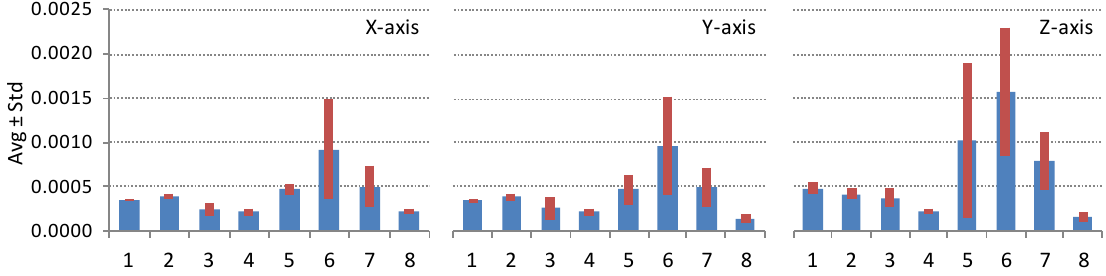
Figure 5. Comparison of average accelerometer noise parameter VRW and its standard deviation for eight different smartphone models. Smartphone models presented are: Galaxy S3, Galaxy S4, iPhone 4, iPhone 5, iPhone 5S, iPhone 6, Nexus 5, Xperia Z1 Compact. The listed smartphone